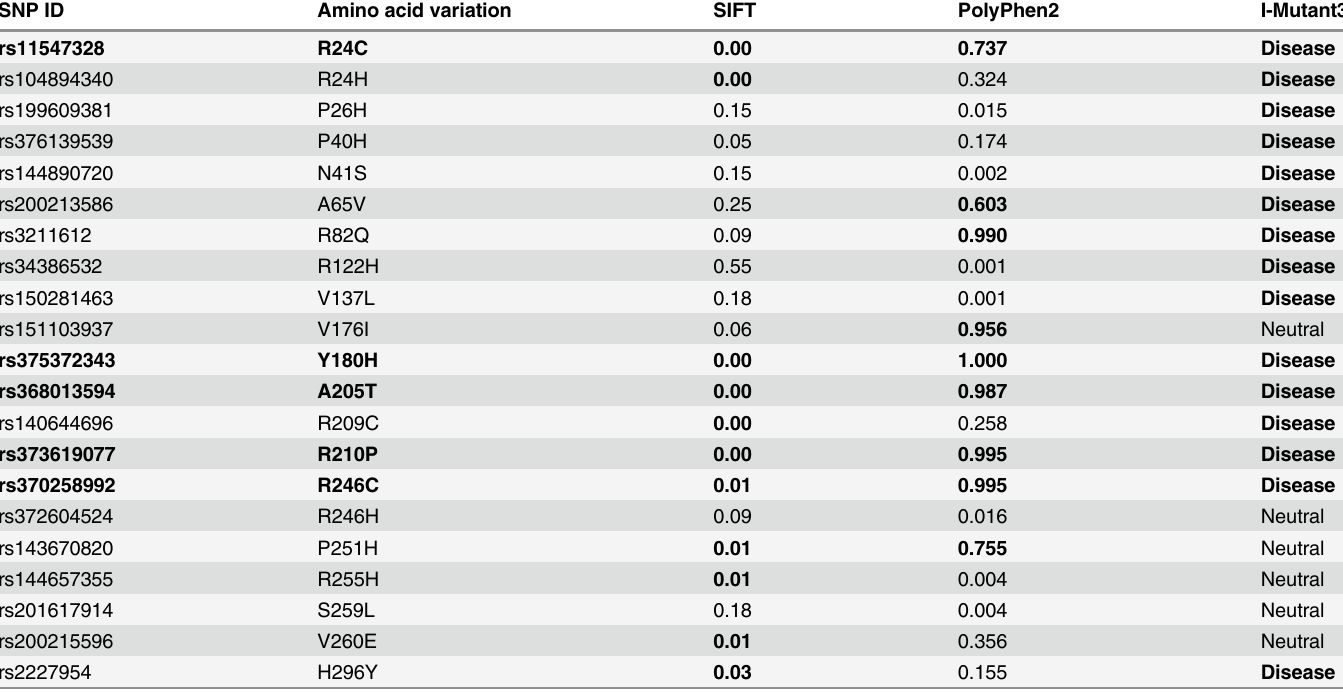
Table 1. List of nsSNPs present in CDK4 gene and their predicted SIFT, PolyPhen2 and I-Mutant3 scores. SNP ID Amino acid variation